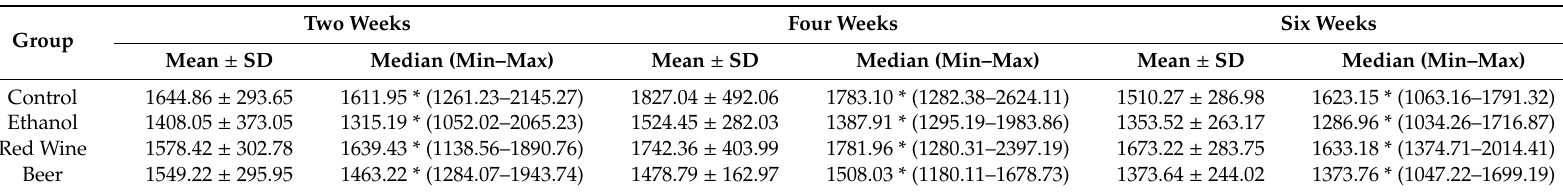
Table 11. Total antioxidant status (TAS) (mM per mg of protein) in the groups of experimental rats stratified by a group and experiment duration. Group